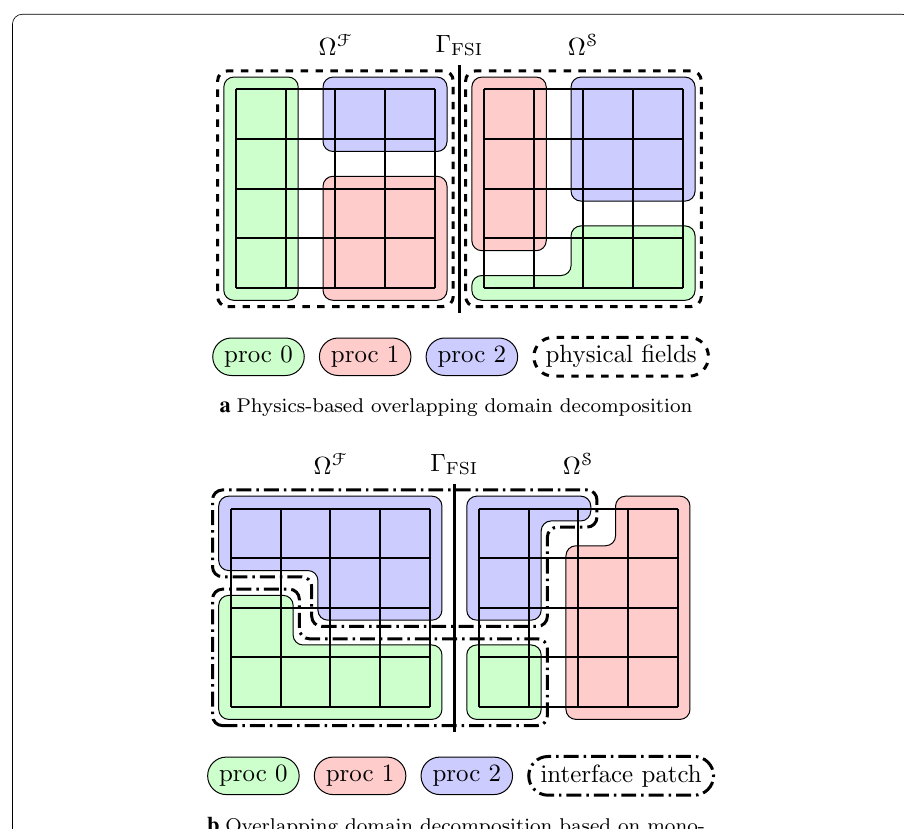
Fig. 2 Overlapping domain decompositions of a FSI problem— Top: At the fluid-structure interface (cid:3) FSI , the domain is partitioned into solid and fluid subdomains indicated by dashed lines. Each field can further be distributed among several processes by an overlapping domain decomposition indicated by the colored patches. Overlap of subdomains is not depicted for clarity of presentation. Bottom: In a decomposition based on a monolithic graph, subdomains span across the interface like ’proc 0’ and ’proc 2’. They are crucial for the effectiveness of the proposed preconditioner. Some processes might not own portions of both fields, e.g. ’proc 1’. Overlap of subdomains is not depicted for clarity of